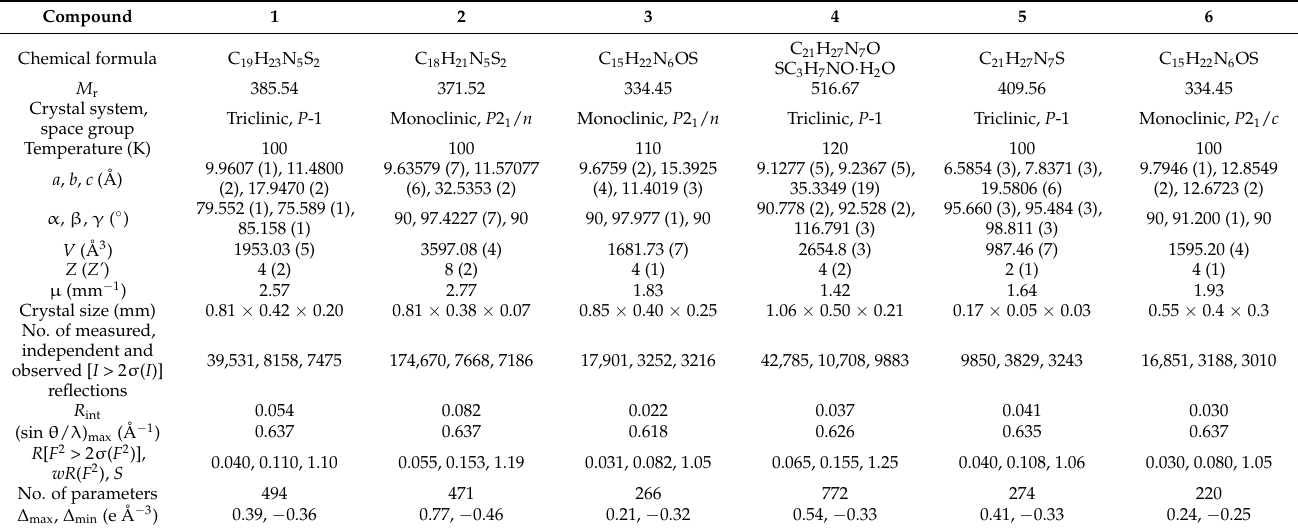
Table 2. Crystal data, data collection and refinement